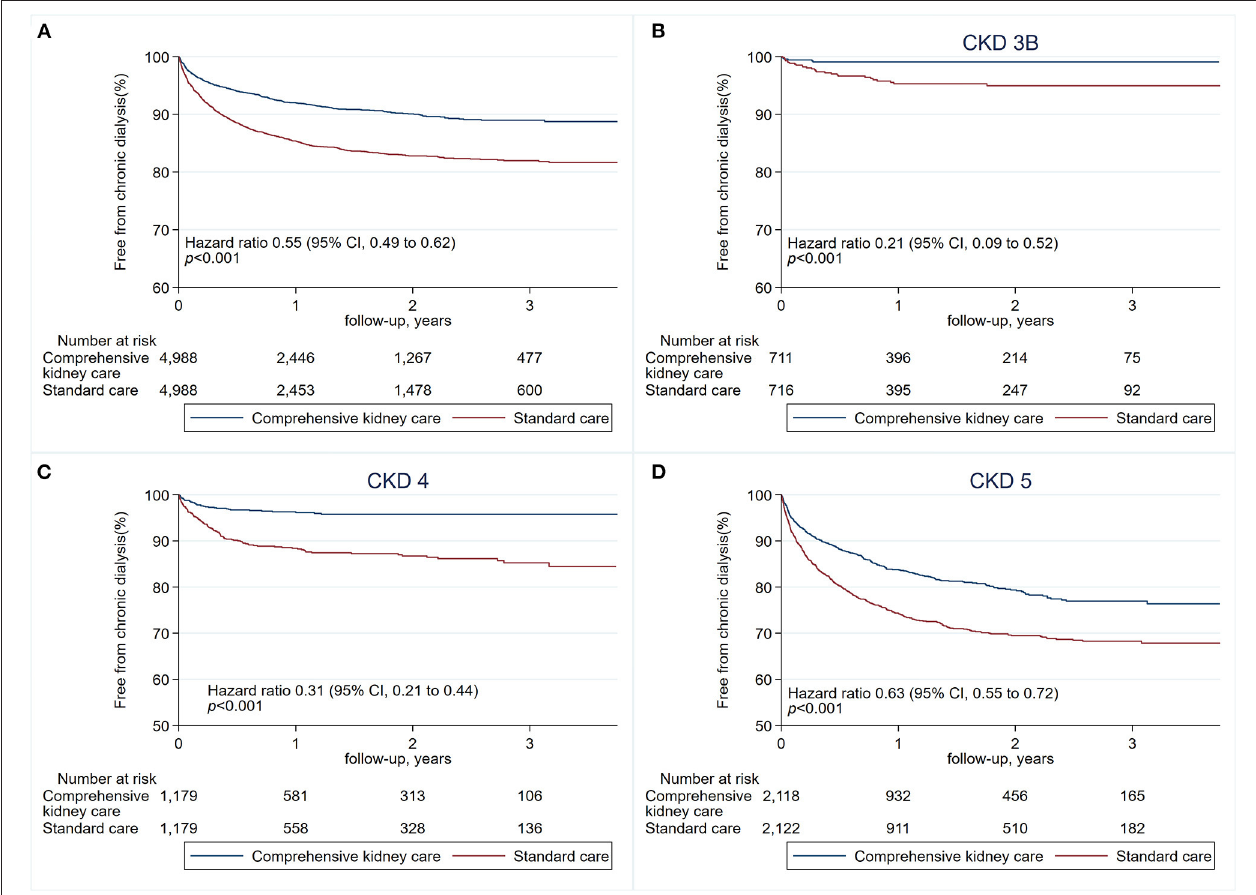
FIGURE 2 | Risks of chronic dialysis or end-stage renal disease (ESRD). The first primary outcome is the risk of chronic dialysis or ESRD (A) , estimated with the Kaplan–Meier method. Hazard ratios, confidence intervals, and P -values were estimated with the Cox proportional-hazards regression model. Risks of chronic dialysis and ESRD when stratified according to chronic kidney disease (CKD) stage 3B (B) , CKD stage 4 (C) , and CKD stage 5 (D)